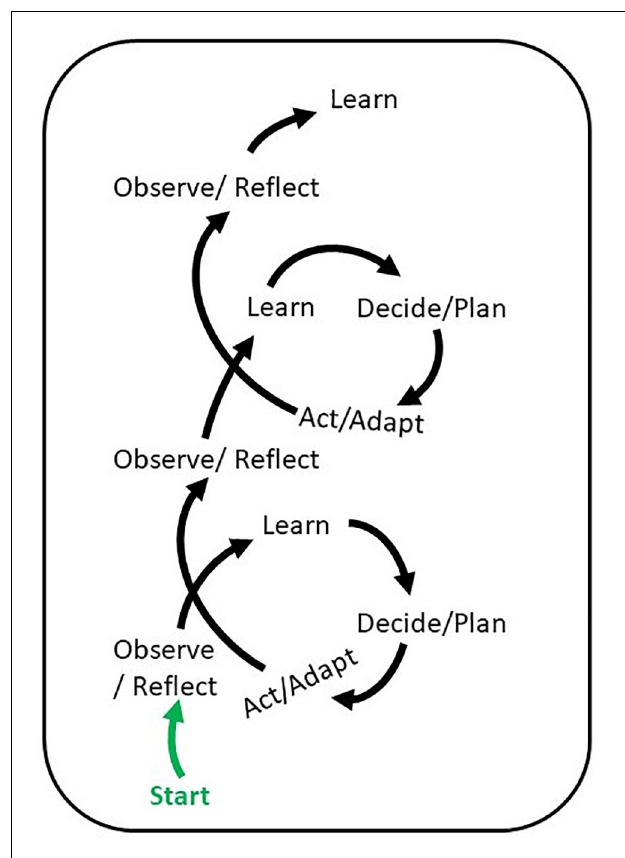
FIGURE 8 | Observation and learning base schematic (adapted by SS Kolipaka from a figure in an anonymous